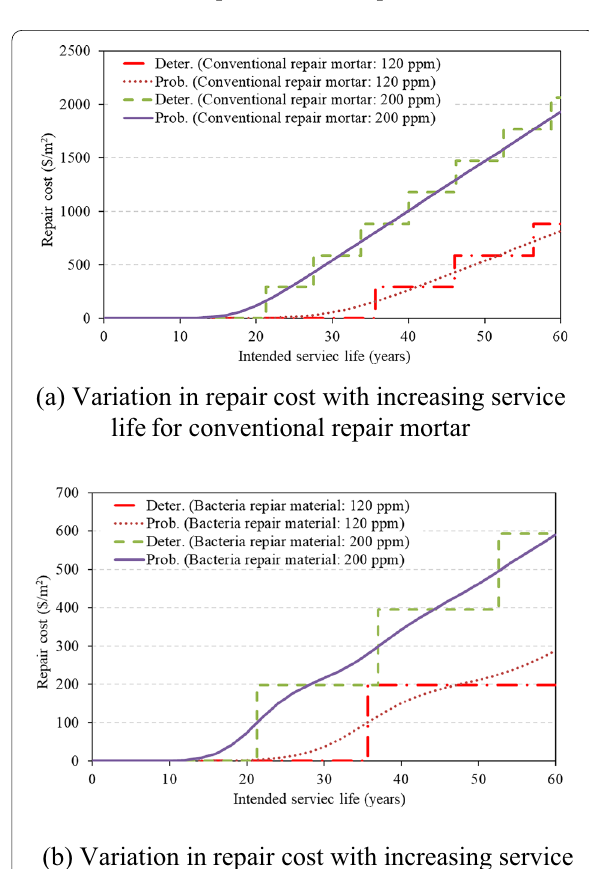
Fig. 7 Variation in repair cost with increasing service life for normal and bacteria repair